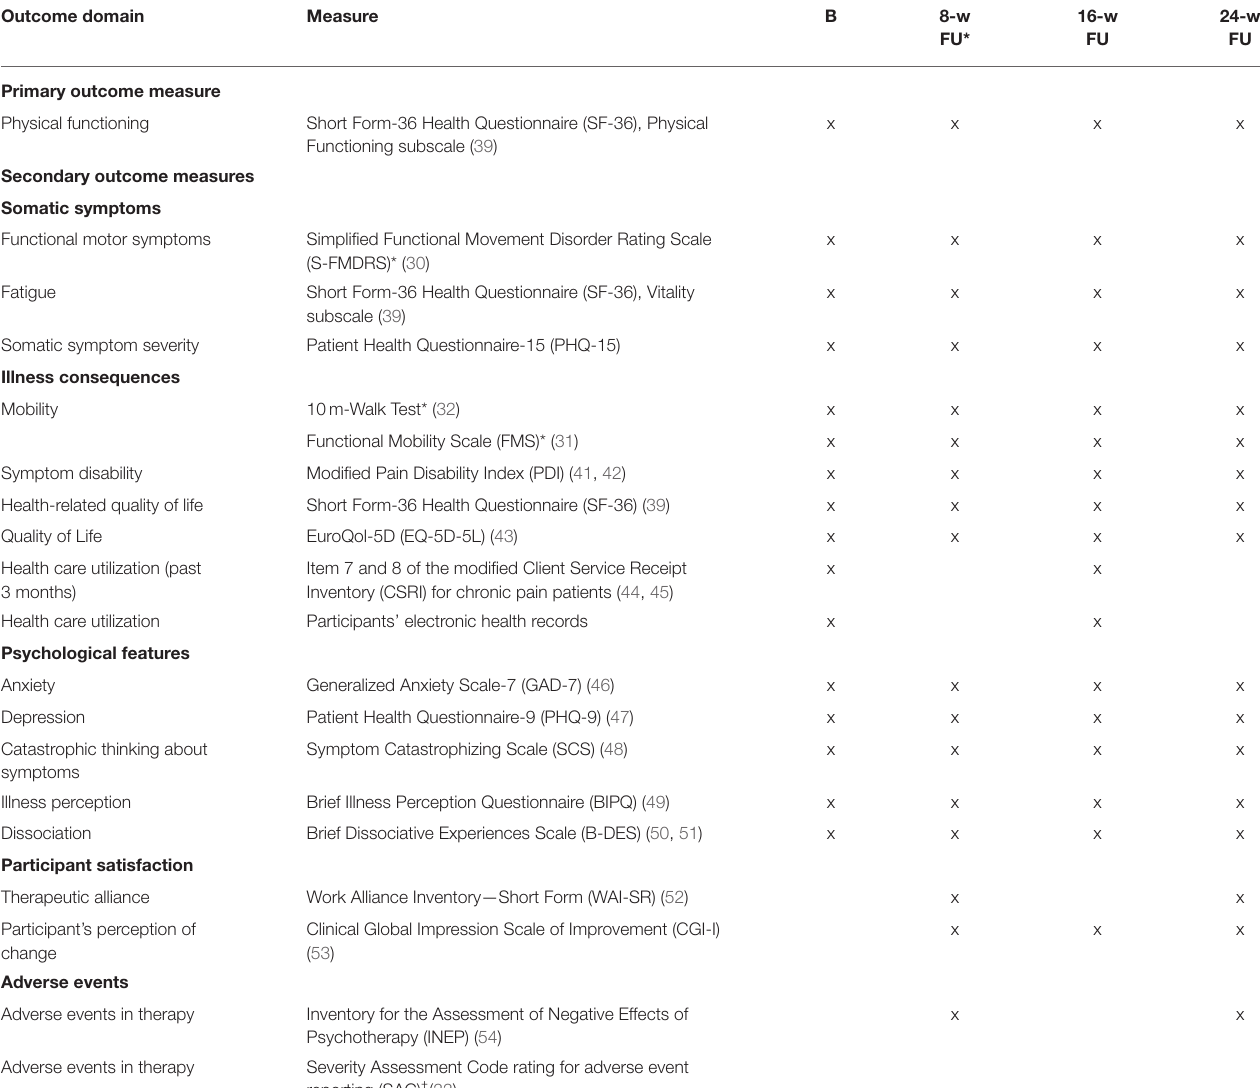
TABLE 2 | Assessments, outcomes, and